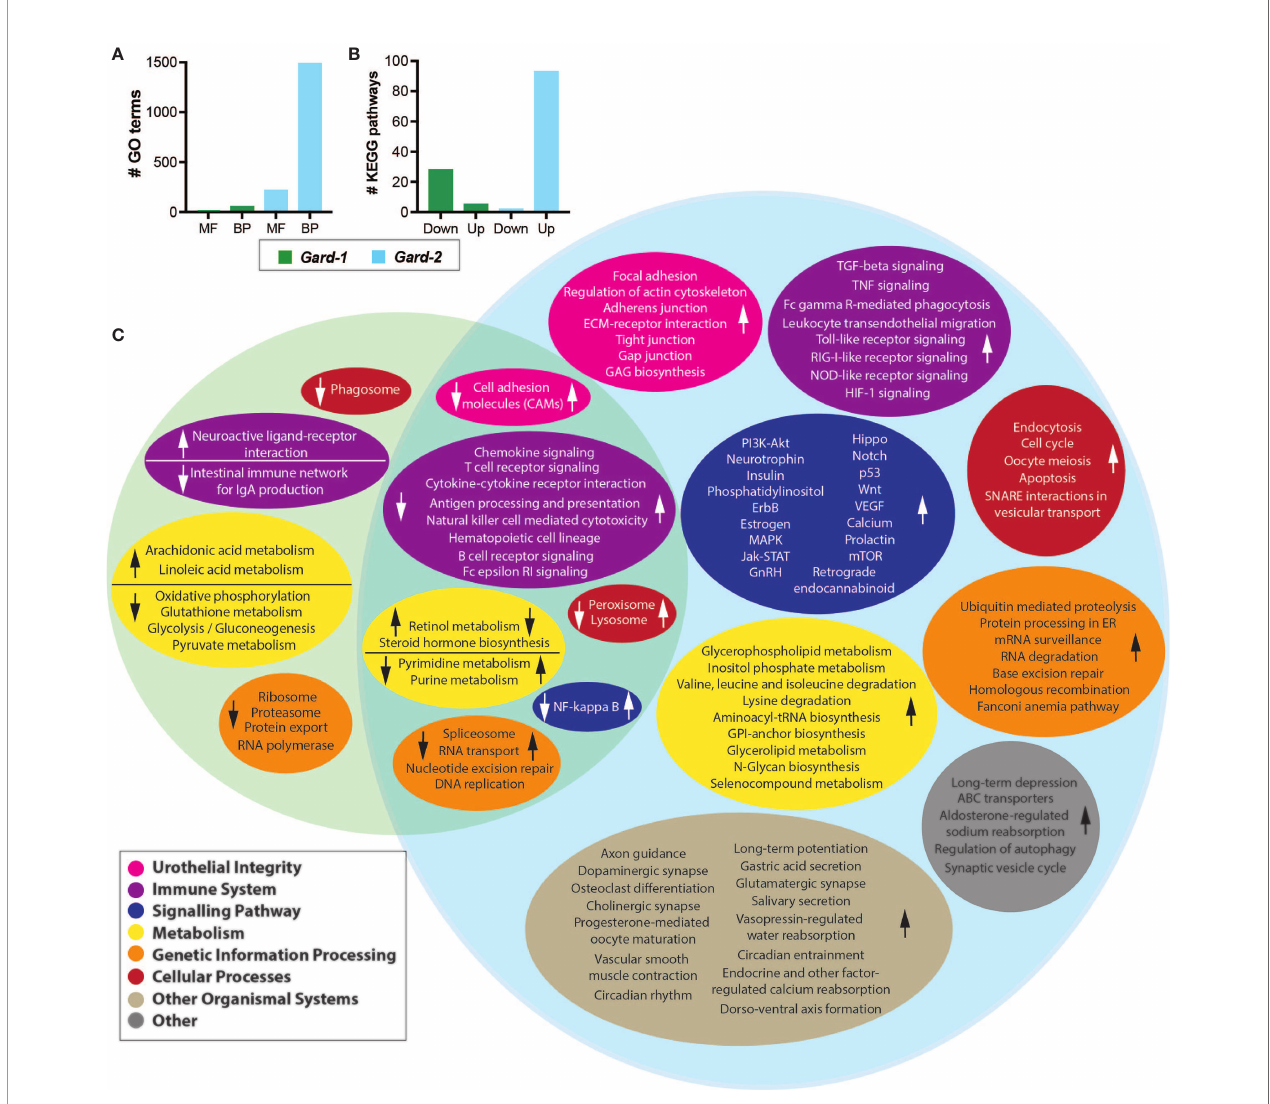
FIGURE 2 | Differential expression analysis. Shown are the host gene expression pathways that were differentially expressed following each Gardnerella (Gard) exposure. (A) The indicates number of Gene Ontology (GO) terms were signi fi cantly up- or down-regulated. MF, molecular functions; BP, biological processes. (B) The indicated number of KEGG pathways were signi fi cantly up- or down-regulated following Gardnerella exposure. (C) The Venn diagram displays KEGG pathways that were signi fi cantly different between PBS-1 and Gard -1 (left, green circle) or PBS-2 and Gard -2 (right, blue circle). Pathways with similar functions are organized into color-coded ovals as indicated in the fi gure legend. The direction of the change in the Gard group relative to the PBS group is indicated by arrows in each colored oval. The overlapping section of the Venn diagram indicates pathways impacted in both comparisons, with the arrows on the left in each colored oval indicating the direction of the change for Gard -1 and the arrow on the right indicating the direction of the change for Gard-